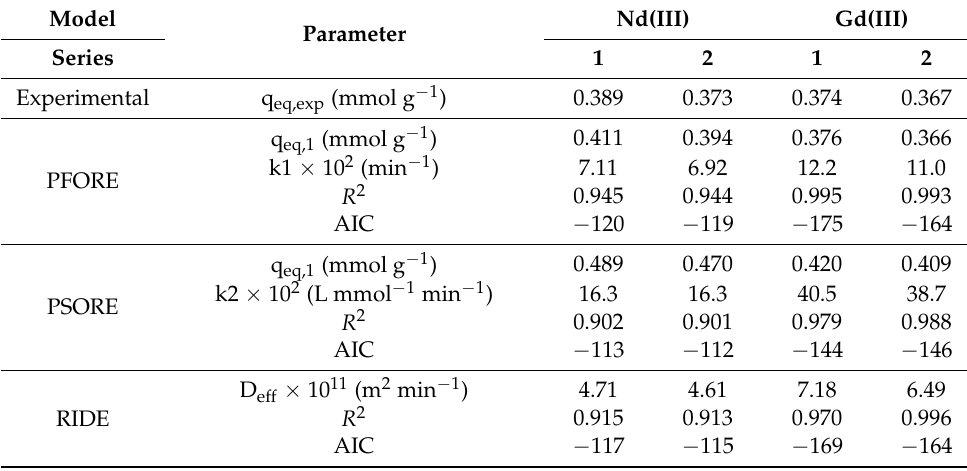
Table 1. Nd(III) and Gd(III) uptake kinetics—parameters for